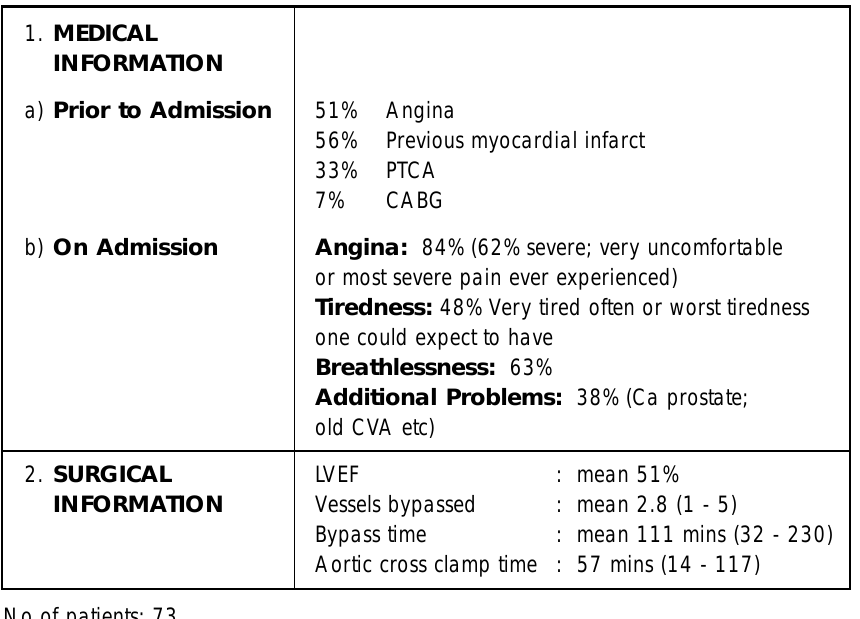
Table 111: Medical and Surgical